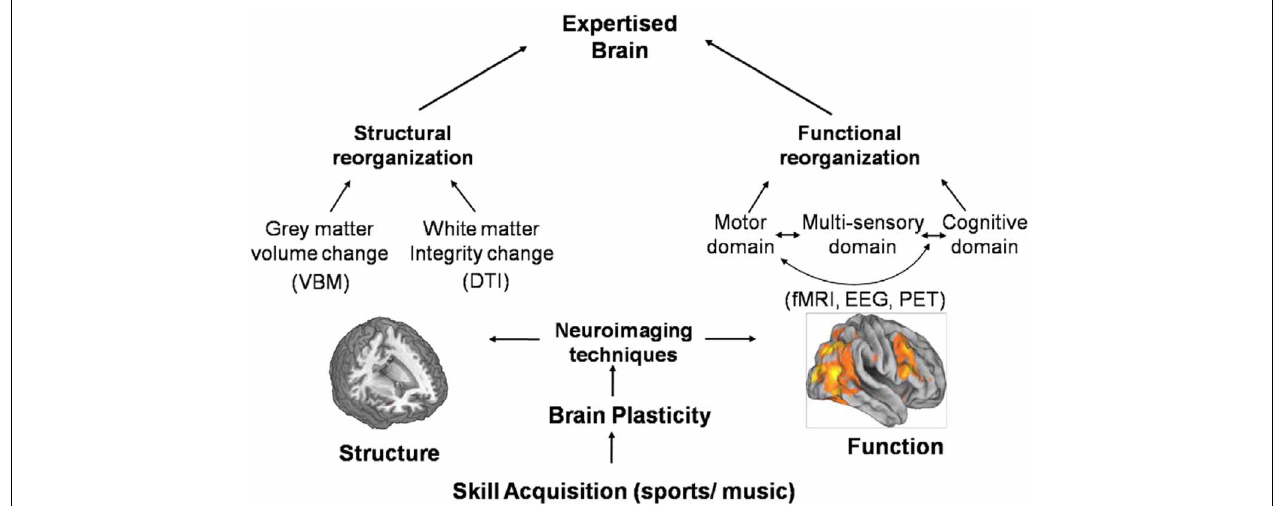
FIGURE 1 | Advances in neuro imaging technique have provided new insights into the neuroplastic changes underlying skill learning and expertise at both structural and functional levels. At structural level, a main finding is increased gray matter volume or density of brain areas